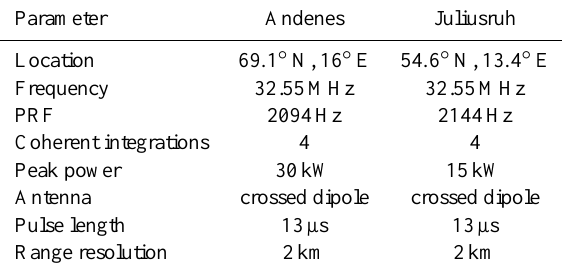
Table 1. Technical details of the used meteor radars. The abbrevia- tion PRF stands for pulse repetition frequency.